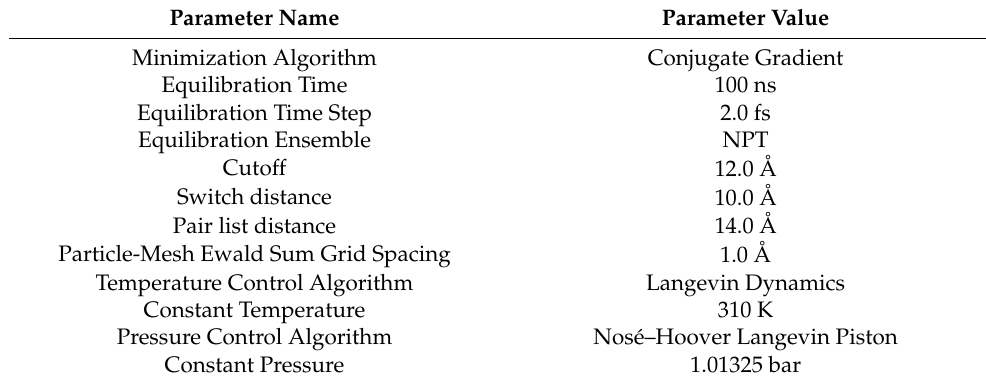
Table 2. Parameters of MD simulation for minimization and equilibration in NAMD.